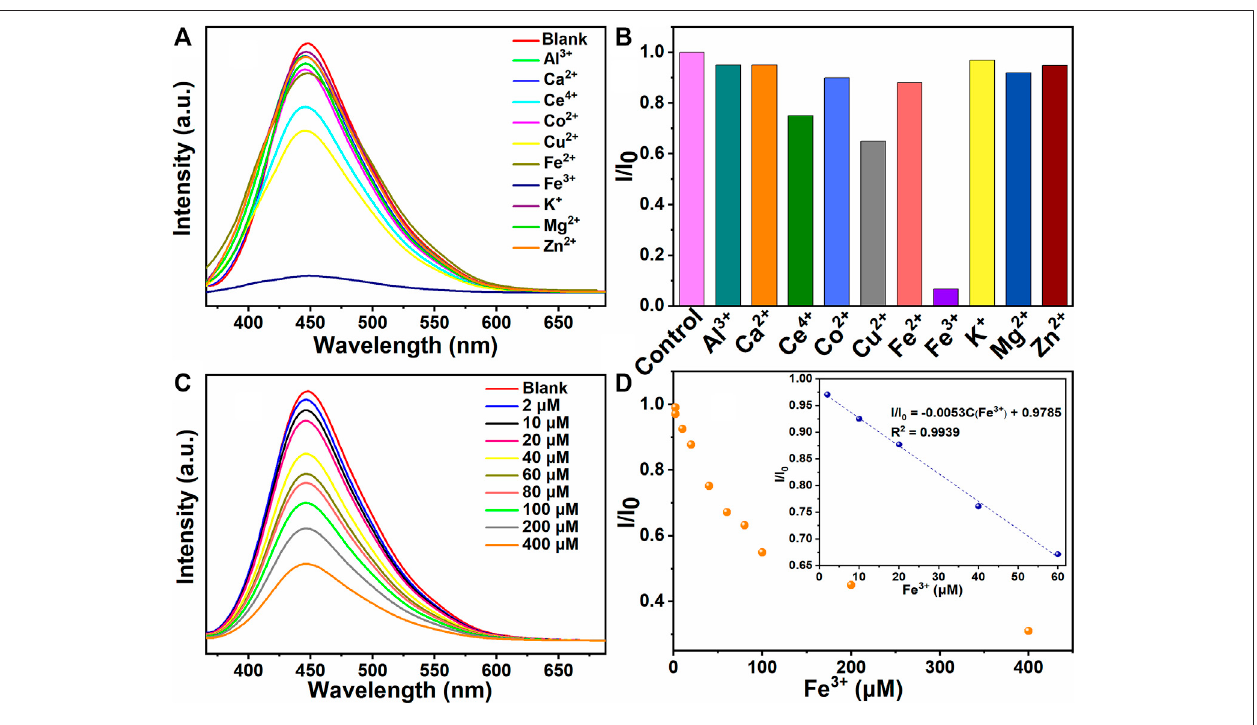
FIGURE 5 | (A) Fluorescent emission spectra of CQDs under various metal ions. (B) The relative fl uorescent intensities (I/I 0 ) of CQDs under various metal ions. (C) Fluorescent emission spectra of CQDs under various Fe 3+ ion concentrations. (D) The dependence of I/I 0 value on the different Fe 3+ ion